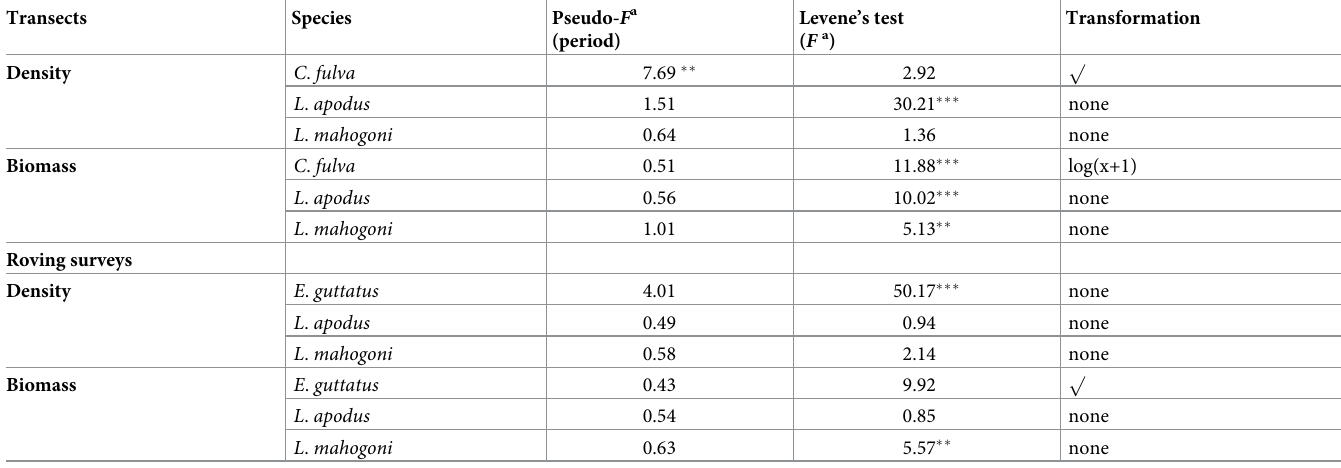
Table 4. Summary of species-specific pairwise tests (MNTZ).